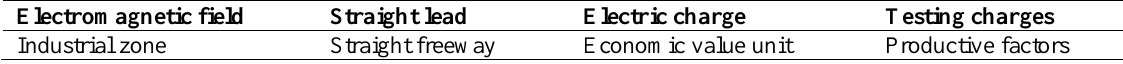
Table 2. Analogy between an industrial zone and an electromagnetic field Electromagnetic